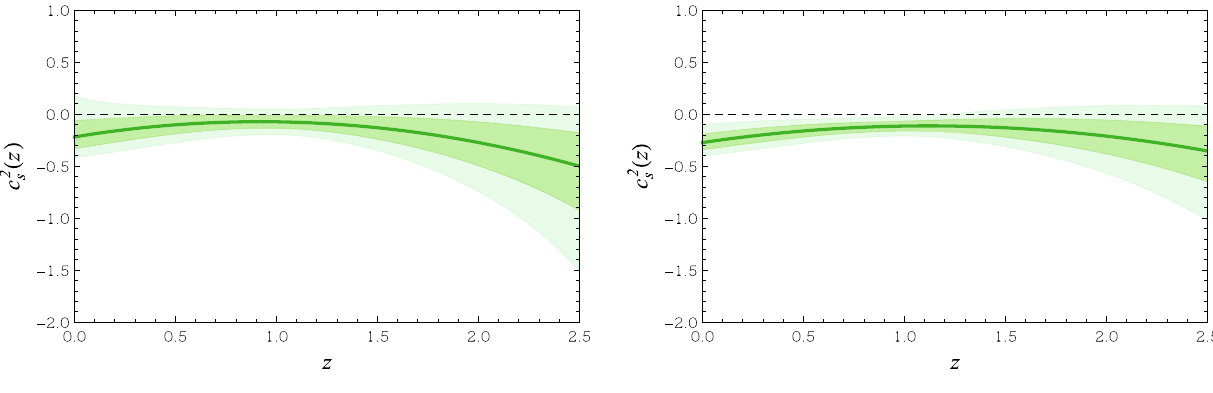
Fig. 6 c 2 s ( z ) vs z with 1 σ and 2 σ CL regions, reconstructed from SN+BAO+CC data (left panel) and SN+BAO+CC+H0LiCOW data (right panel). The dashed line is the division of dark energy